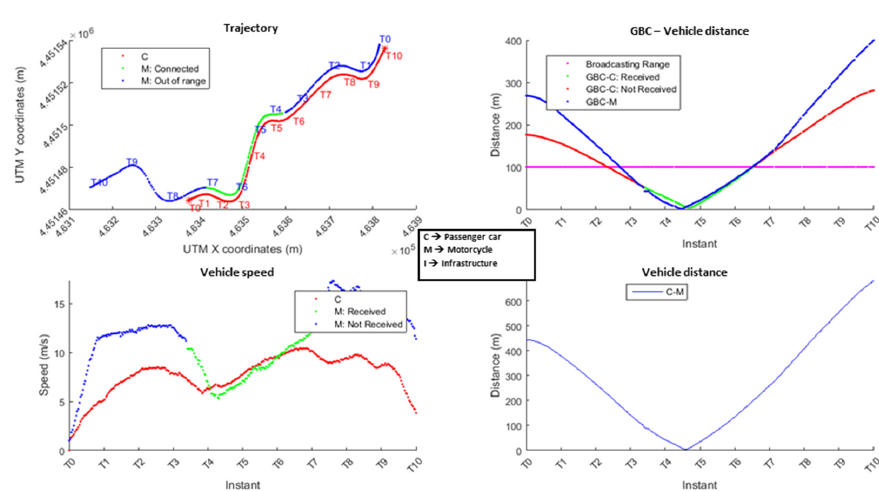
Figure 7. Results of Test 3 without RSU.